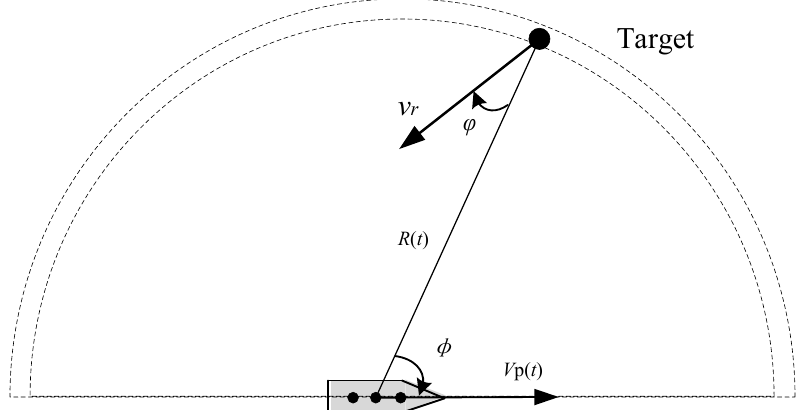
Figure 1. The diagram of the relative position of the moving target and shipborne platform.